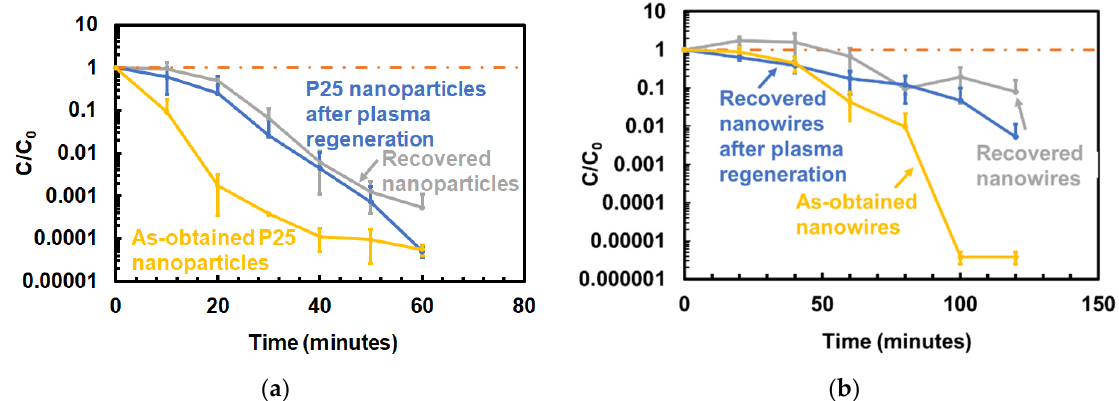
Figure 3. Kinetics of E. coli disinfection in recovered and regenerated photocatalysts for: ( a ) Aeroxide P25 ® nanoparticles; ( b ) TiO 2 porous nanowires. In both cases, regeneration of the photocatalyst surfaces using plasmas resulted in the increase in the photocatalyst disinfection kinetics, compared to their as-recovered counterparts.